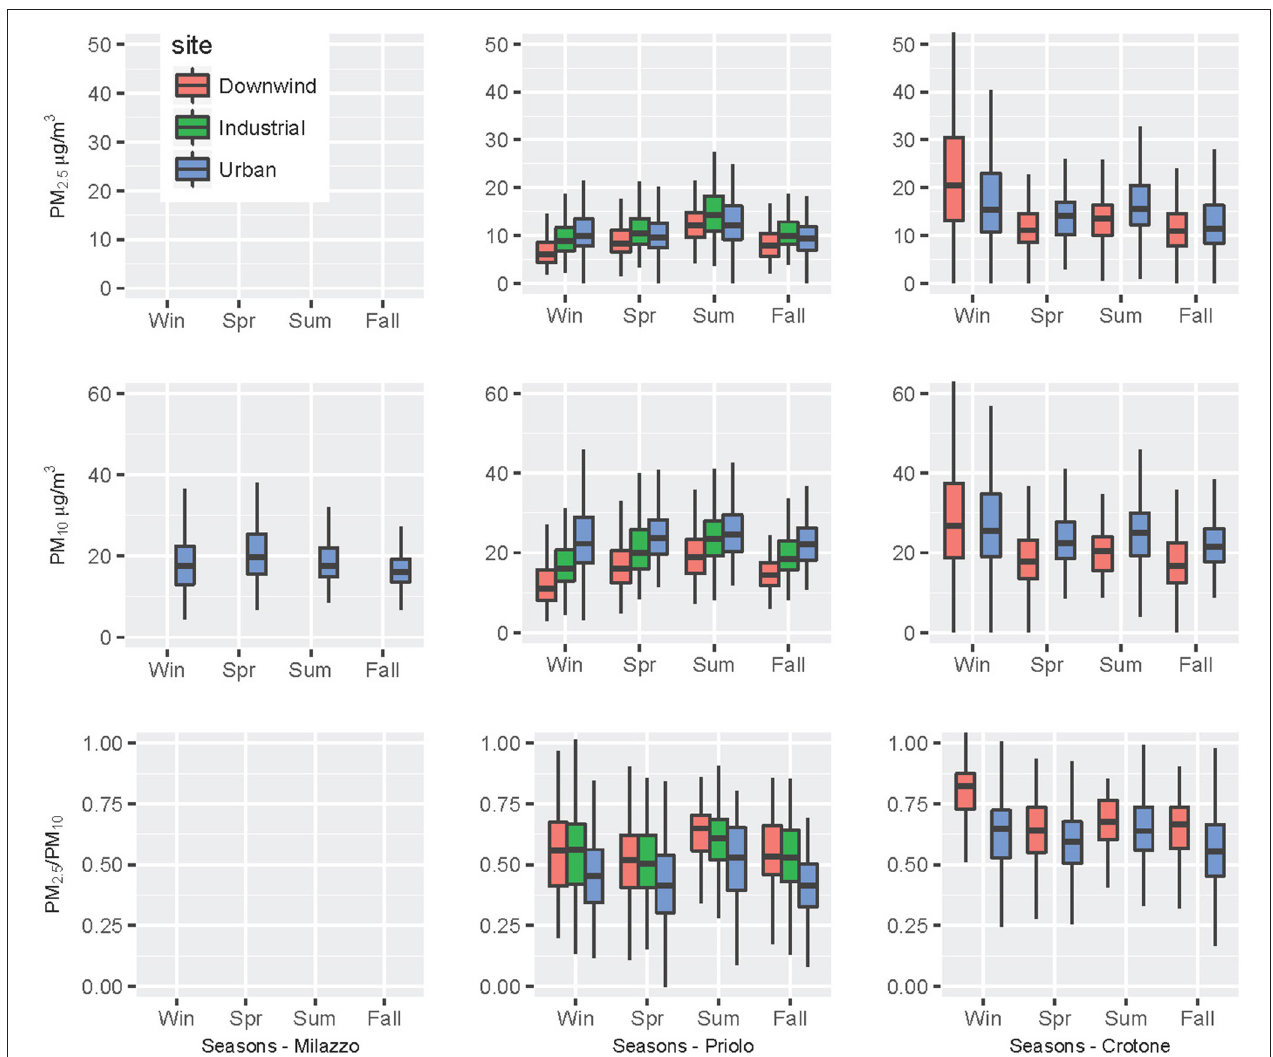
FIGURE 7 | Box plot of PM 2.5 , PM 10 , and PM 2.5 to PM 10 ratio daily means grouped by AERCA and season. Each column corresponds to a different AERCA site, according to Table 1